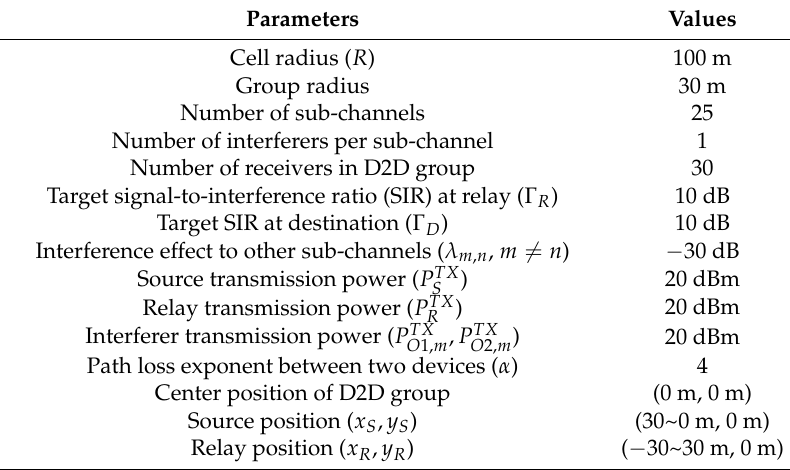
Table 1. Simulation parameters for Figures